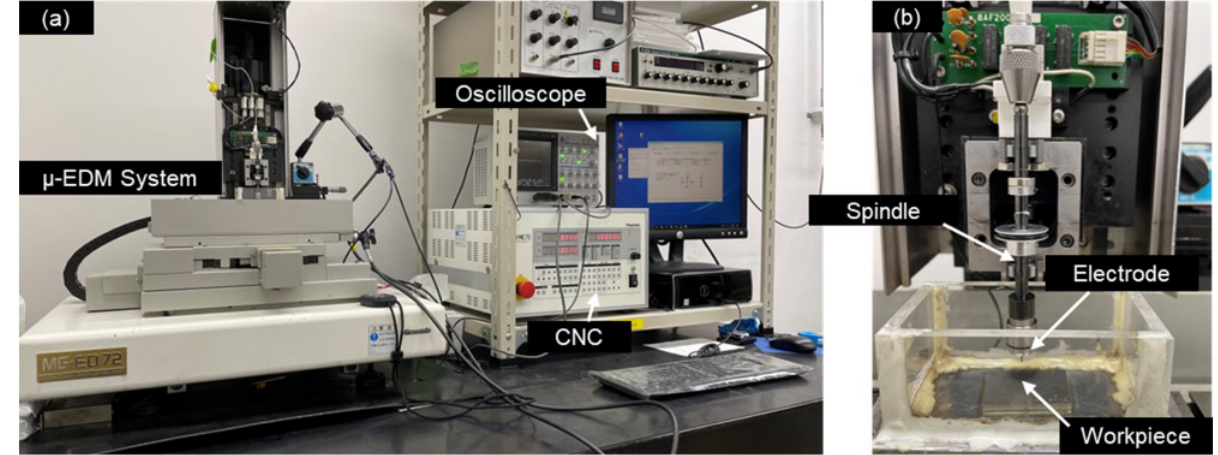
Figure 2. Photograph of ( a ) µ -EDM system, ( b ) electrode and workpiece arrangement.